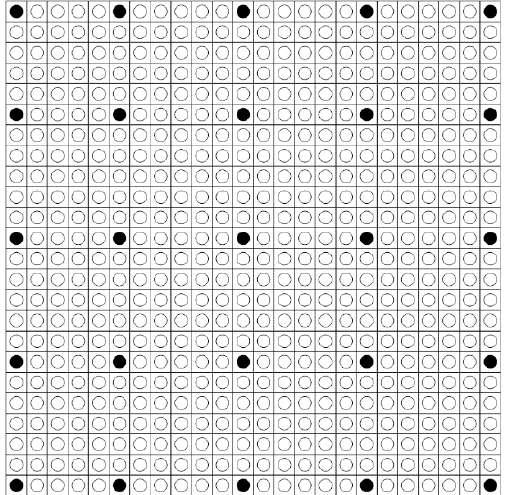
Figure 10. Configuration of the proposed technology when it is used in SPAD arrays.